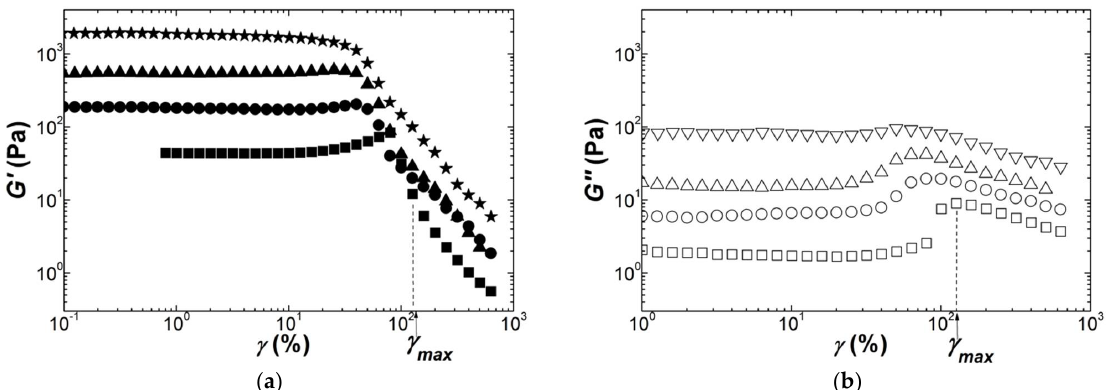
Figure 6. Response of Kappa2 gels (squares: 0.5 wt.%; circles: 0.75 wt.%; up triangles 1.1 wt.%; stars: 1.5 wt.%) to a sweep in the dynamic shear strain γ at 1 Hz and 20 °C: ( a ) storage modulus G′ ; ( b ) loss modulus G ″. γ max signals the strain where G ″ passes through a local maximum for the gel with 0.5 wt.% Kappa2.